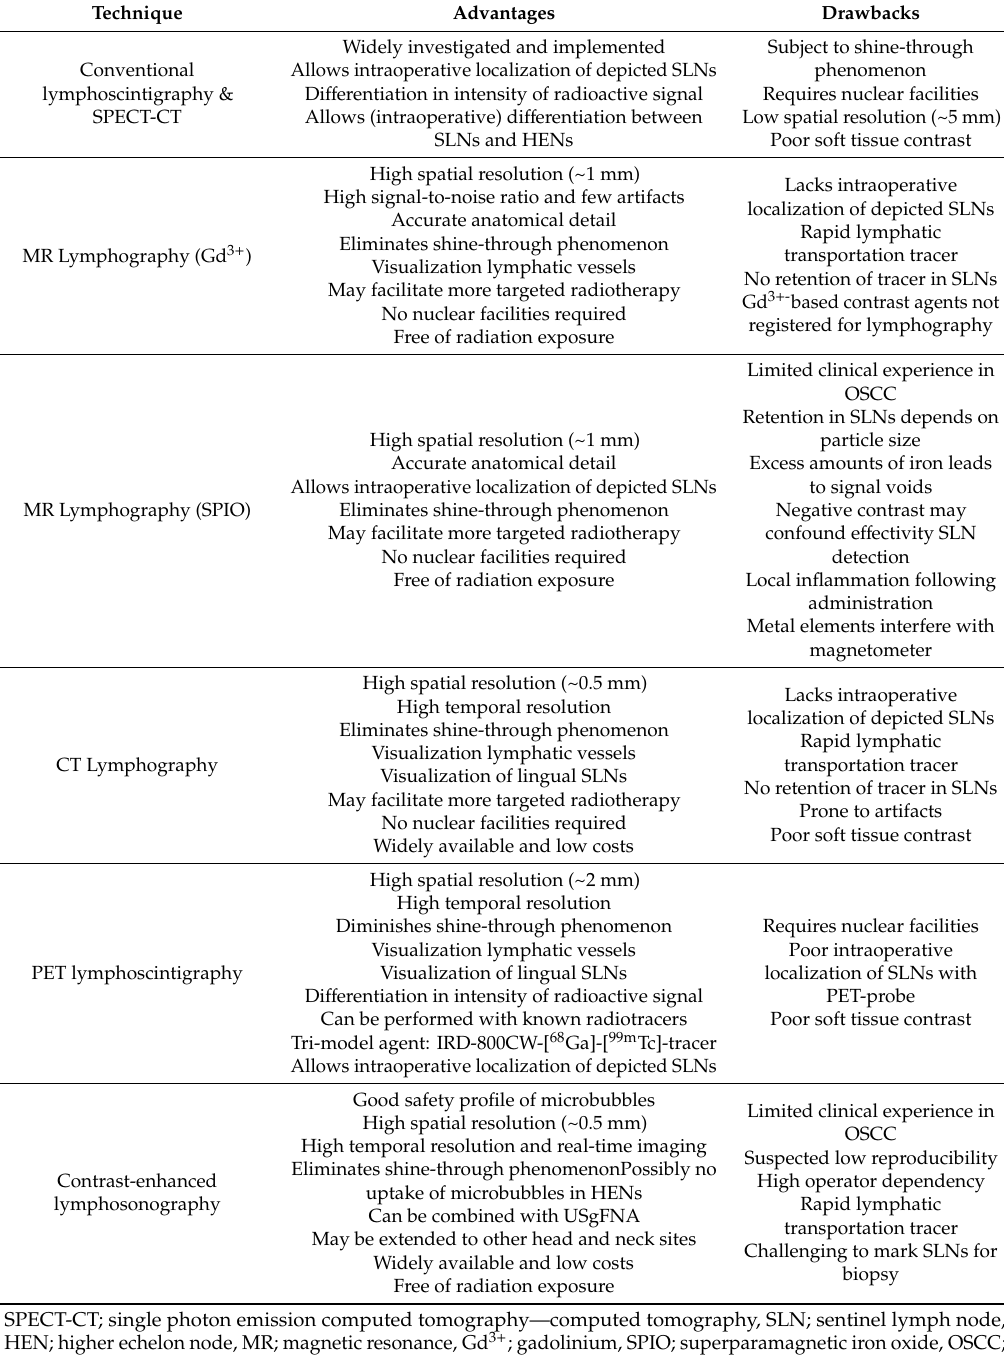
Table 2. Merits and drawbacks per